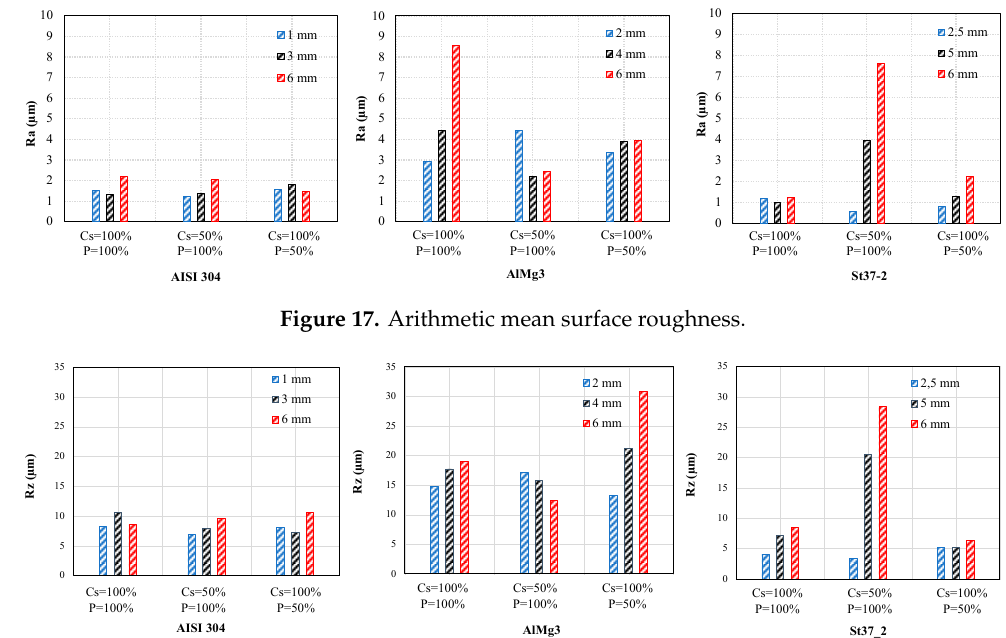
Figure 18. Arithmetic mean surface roughness.